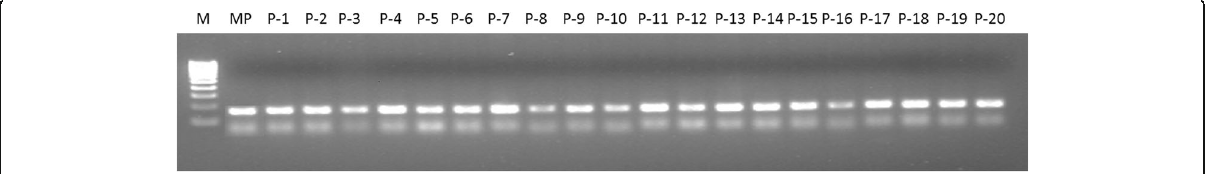
Fig. 2 The fragments obtained with primer SSR11, ladder, MP (mother plant), P-1 to P-20 plants generated in vitro